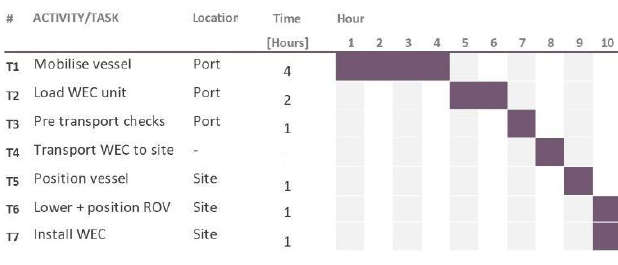
Fig. 4. Work sequence